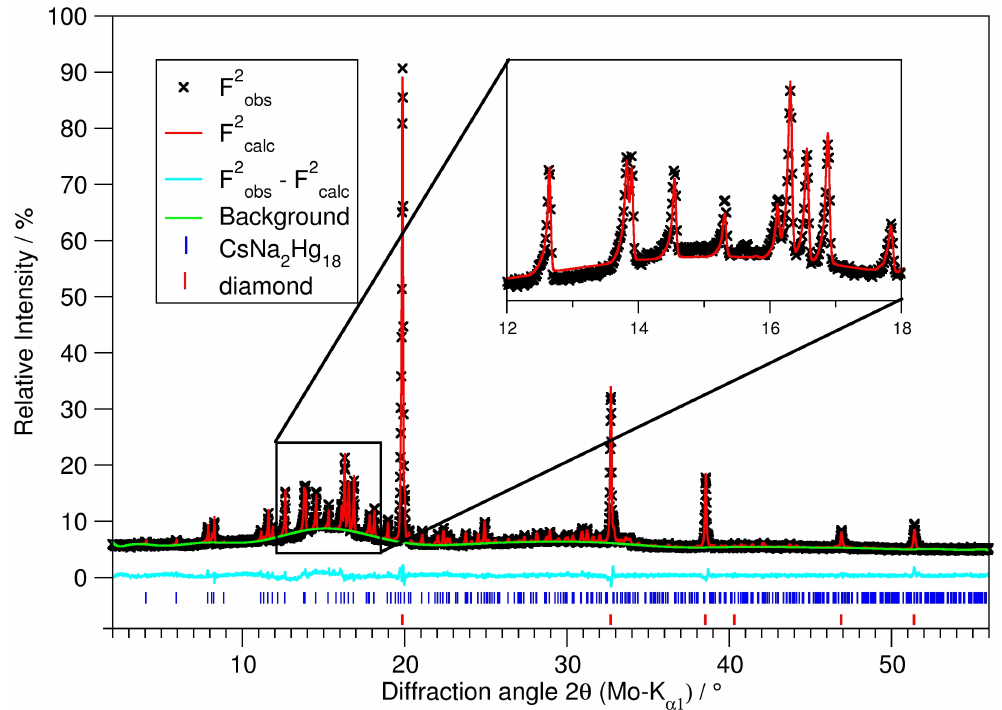
Figure 6. Rietveld refinement on a sample of phase-pure CsNa 2 Hg 18 , diluted with diamond powder. For details on the refinement, see Table 7. Table 7. Crystallographic data and details on a Rietveld refinement of a phase-pure sample of CsNa 2 Hg 18 as a result of an optimised synthesis. For a graphical representation of the refinement, see Figure 6. Refinement was performed with the Topas suite [60]. Below: refined fractional coordinates. In order to reach full convergence, all atoms were refined with identical values for B eq of 2.39(9) pm 2 . Standard deviations are given in units of the last digits in